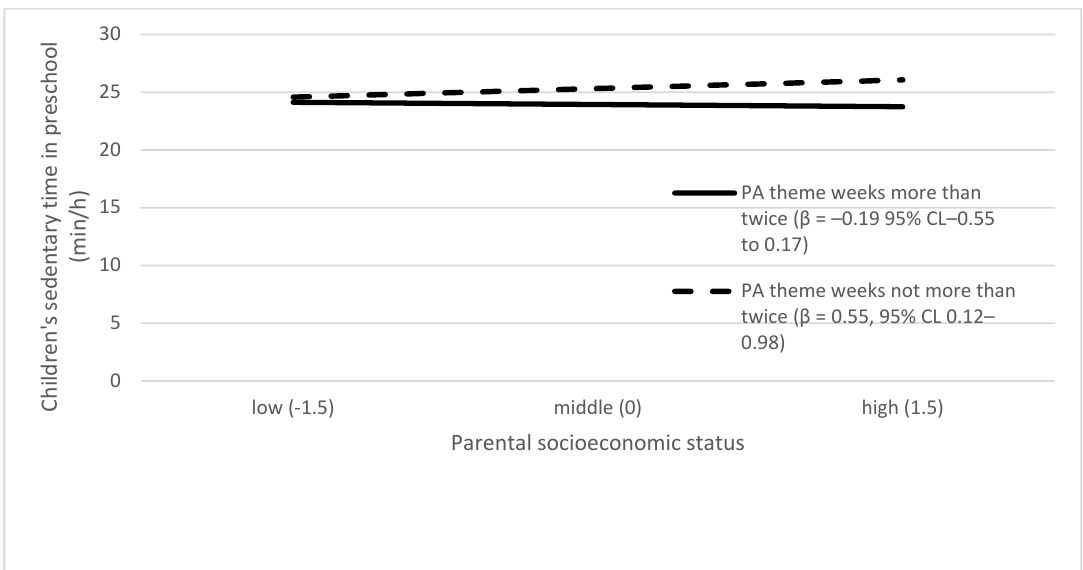
Figure 2. Interaction between SB theme weeks and parental socioeconomic status in predicting children’s preschool sedentary time. Lines in the graphs in Figure 2 represent the dichotomized values yes, there have been sedentary behavior (SB) theme weeks (solid line) and no, there have not been SB theme weeks (dashed line).